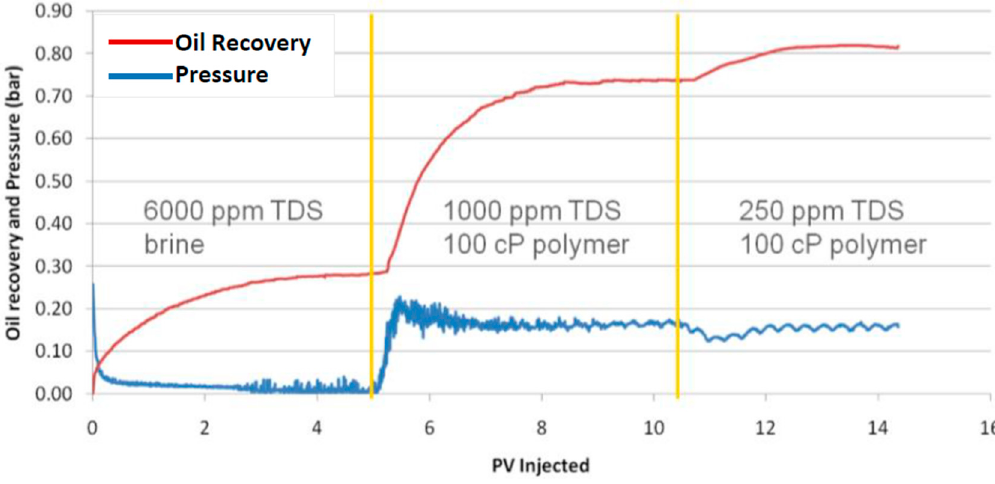
Figure 16. Oil recovery and pressure trend values for LSPF in a reservoir core [119].